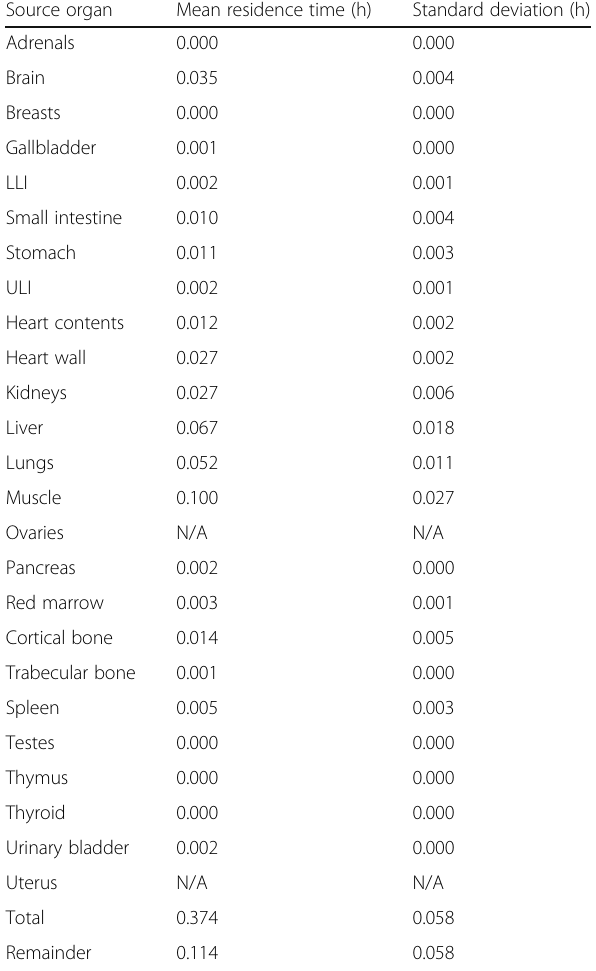
Table 2 Residence times of 11 C-BU99008 in